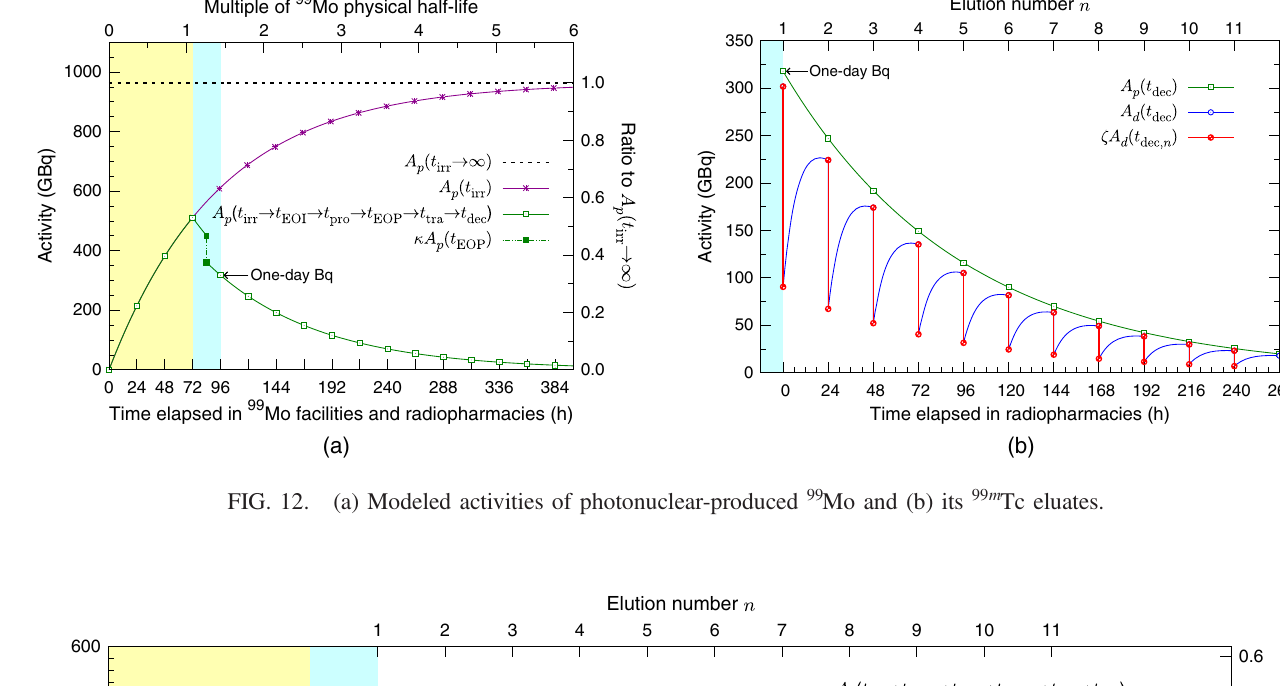
FIG. 12. (a) Modeled activities of photonuclear-produced 99 Mo and (b) its 99 m Tc eluates.